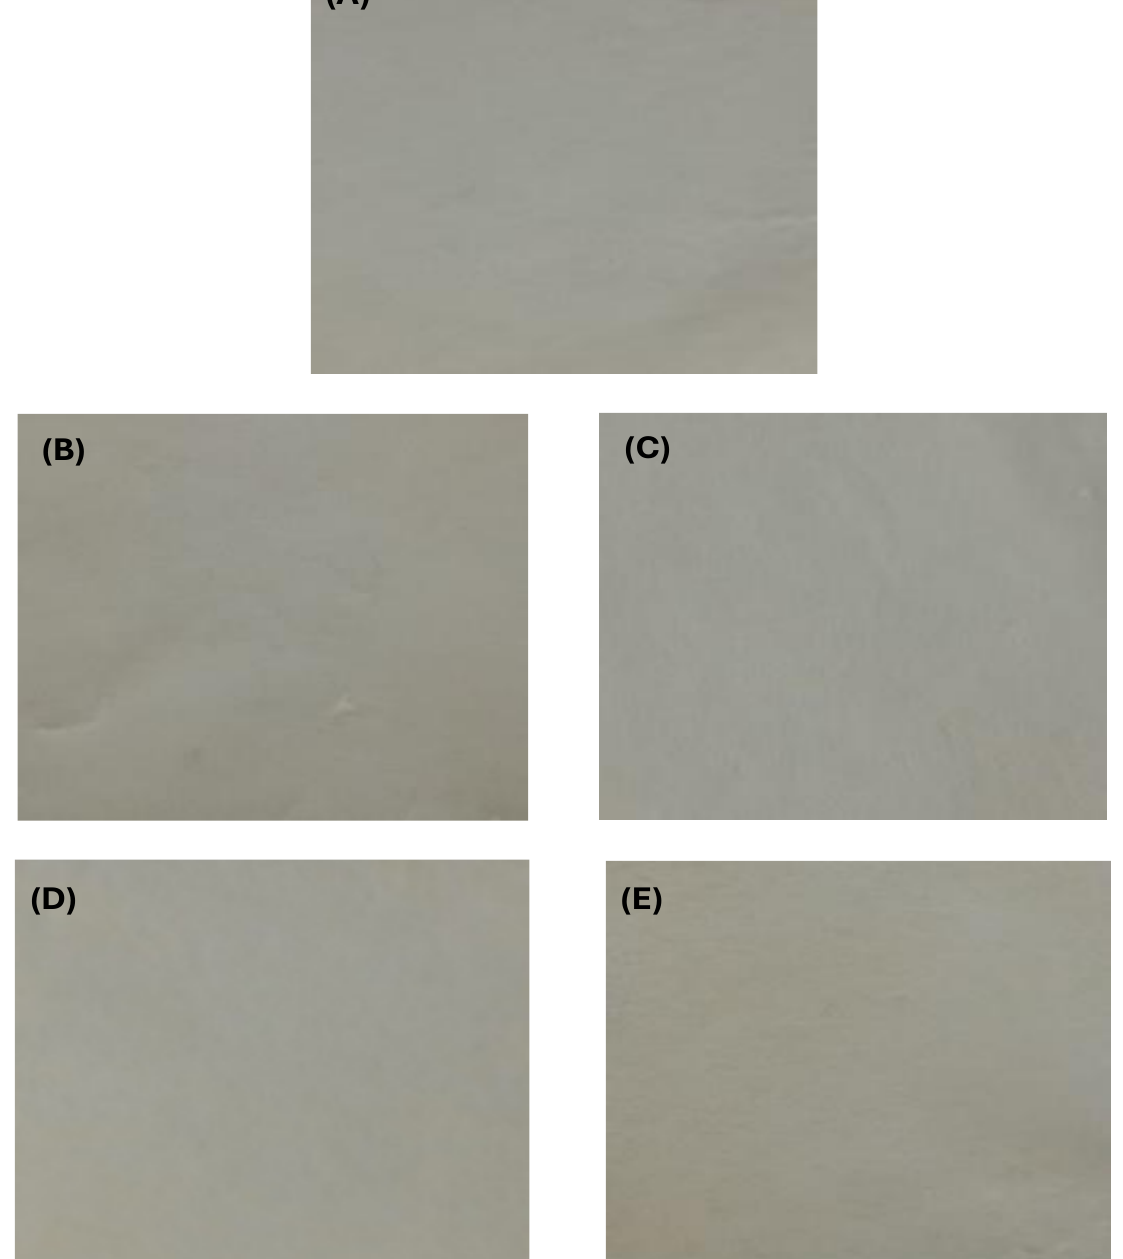
Figure 2. Appearance of chitosan–NGRS based edible film incorporated with and without EOs. Note: The different letters shown in the figure represents significant differences between means. ( A ) represents control film; ( B ) represents garlic oil added film; ( C ) represents galangal oil added film; ( D ) represents turmeric oil added film; ( E ) represents kaffir lime oil added film.